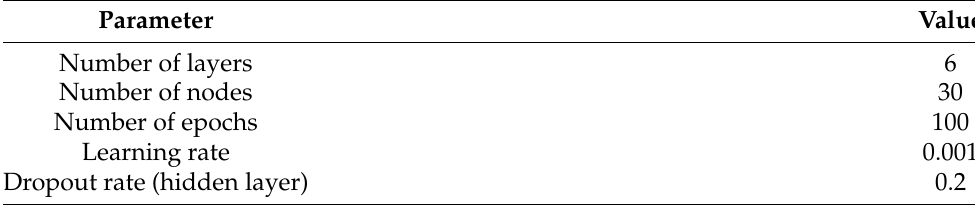
Table 2. LSTM network structure used in this